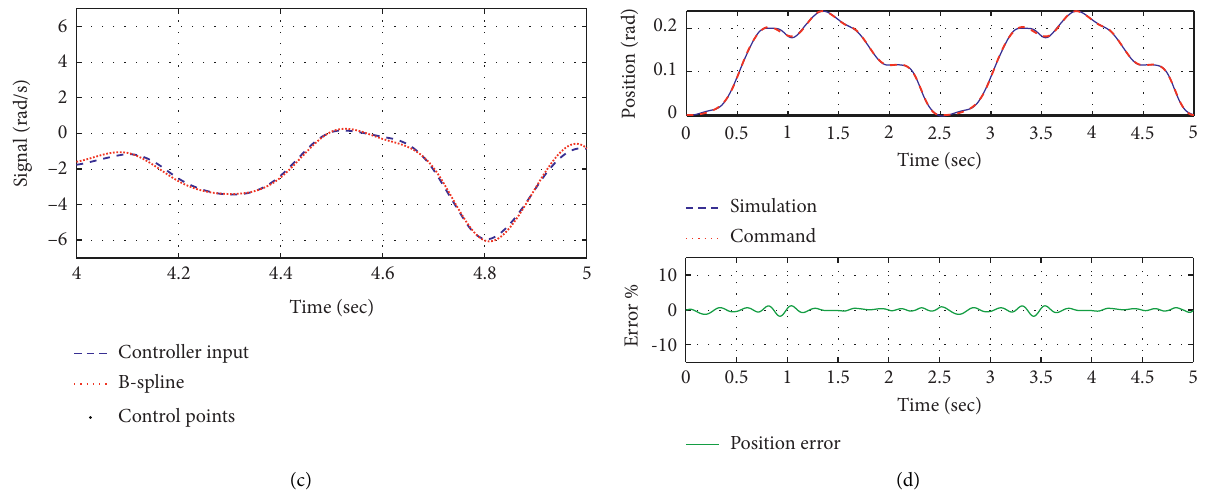
Figure 4: Input modification scheme of manipulator controller based on improved B-spline optimization (control points with nonuniform distribution). (a) Controller input and compensator output in part 1. (b) Controller input and compensator output in part 2. (c) Controller input and compensator output in part 3. (d) Comparison and error of reference position and measurement position.